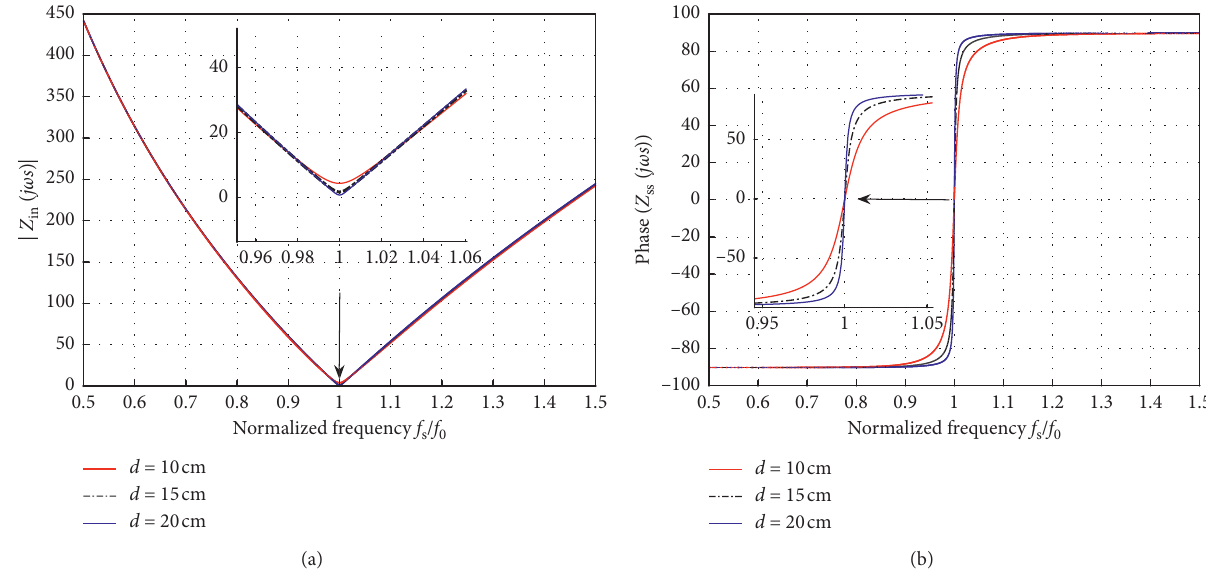
Figure 5: Input impedance as function of the normalized frequency ( F (b) phase of Z in ( f 0 � 10kHz, R p � 1.15 Ω , R s � 0.78 Ω , L p � 4.7mH, L s � 2.9mH, C p � 55 η F C s � 88 η F, R e � 20 Ω ).